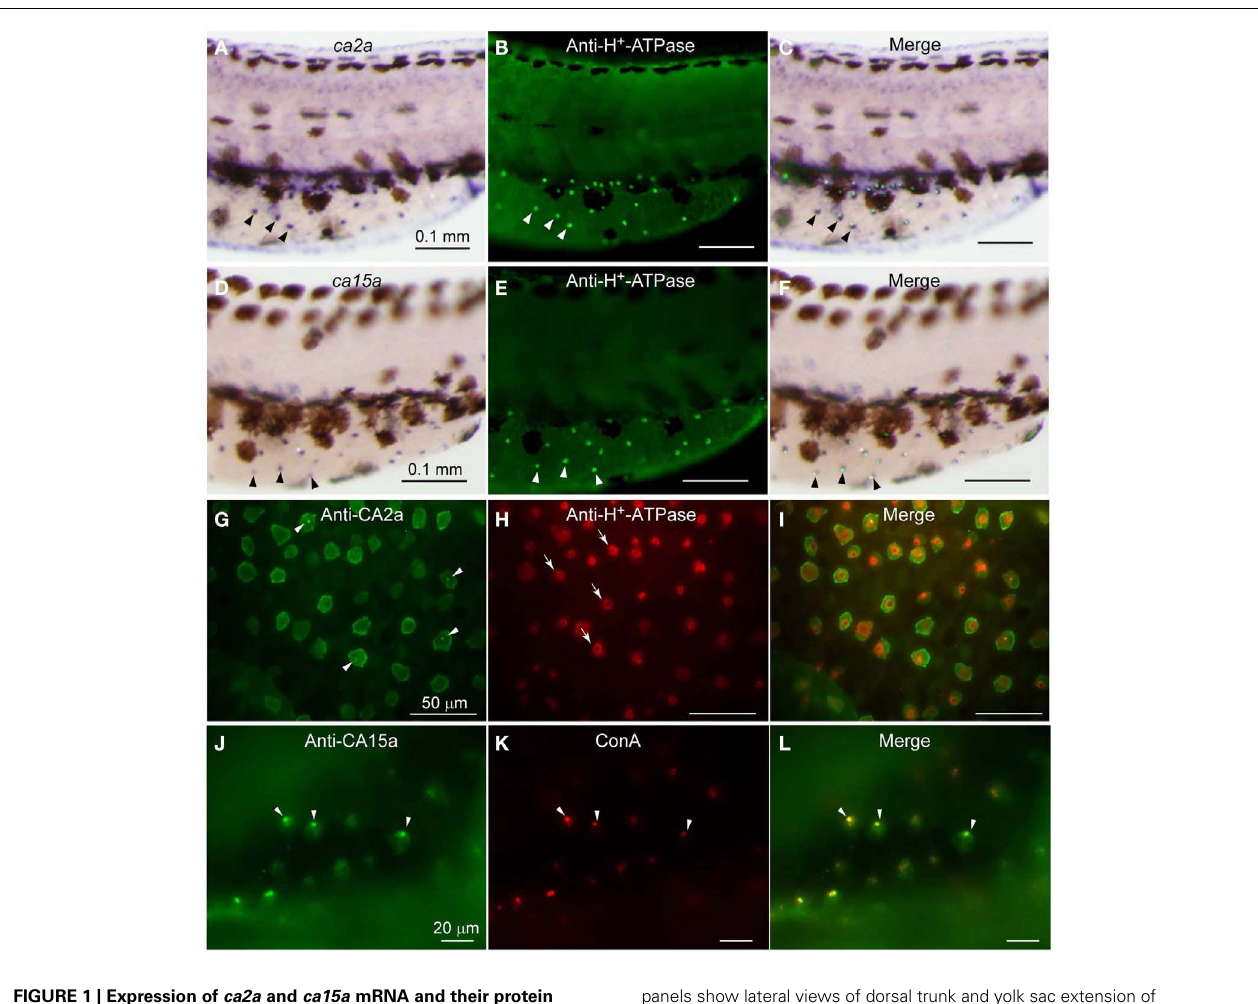
FIGURE 1 | Expression of ca2a and ca15a mRNA and their protein products in H-MRC. Zebrafish larvae of 55-hpf were probed for expression of the indicated genes (A,D) and their products (G,J) , and the types of positive cells were identified by costaining with anti-H + -ATPase (B,E,H) and concanavalin A [ConA, (K) ], which are markers for H-MRC. Right panels (C,F,I,L) are merged images. All